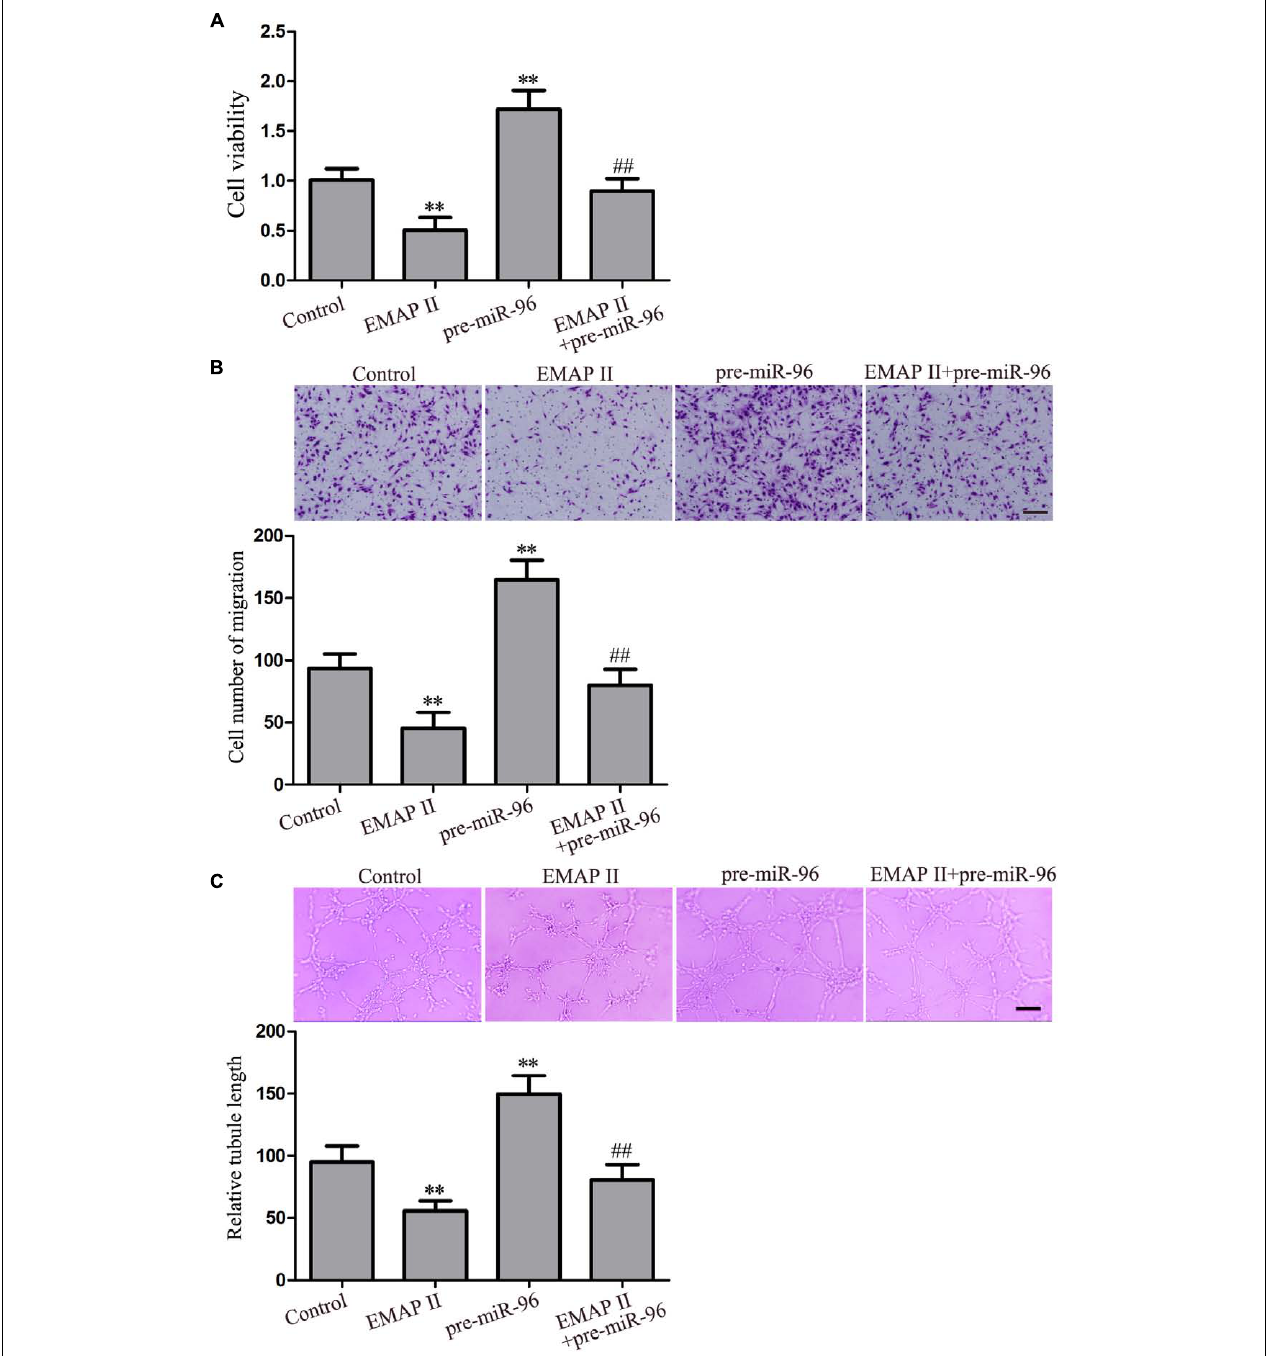
FIGURE 7 | Effect of EMAP II and miR-96 over-expression on the viability, migration, and tube formation of GECs. (A) CCK8 assay to evaluate the effect of EMAP II and miR-96 over-expression on the GECs viability. (B) Transwell assay to evaluate the effect of EMAP II and miR-96 over-expression on the GECs migration. Scale bar = 80 µ m. (C) In vitro tube formation assay to evaluate the effect of EMAP II and miR-96 over-expression on the GECs tube formation. Scale bar = 100 µ m. Data represent means ± SD ( n = 5, each). ∗∗ P < 0.01 vs. control group, ## P < 0.01 vs. EMAP II group.